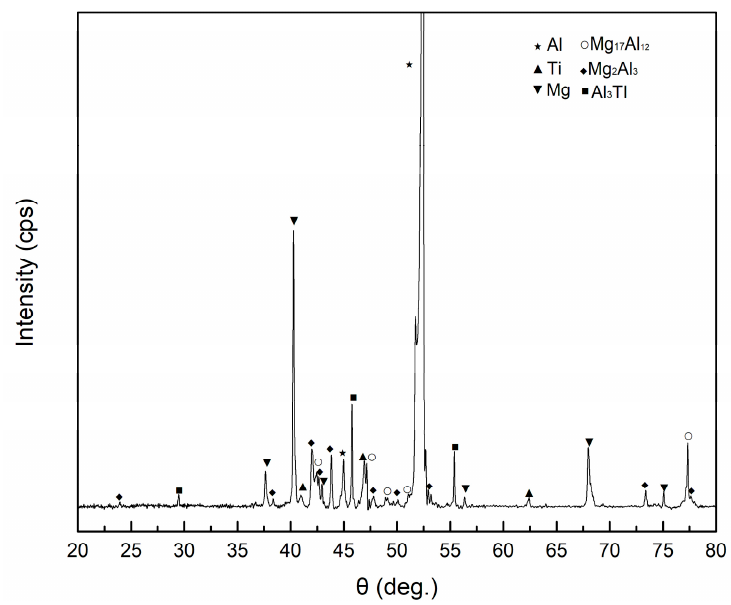
Figure 3. XRD patterns of a cross-section of AlMgTi-based MIL composite.